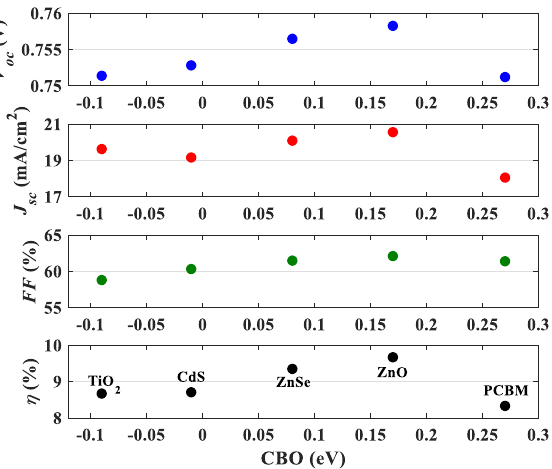
Figure 17. Effect of electron affinity of ETL on PCE.